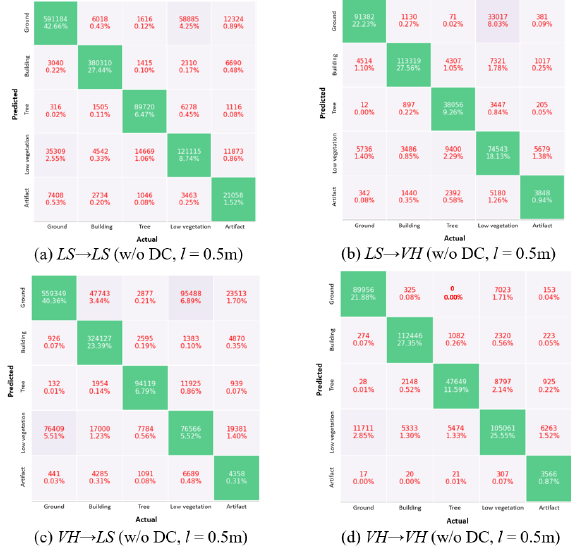
Figure 4. Confusion